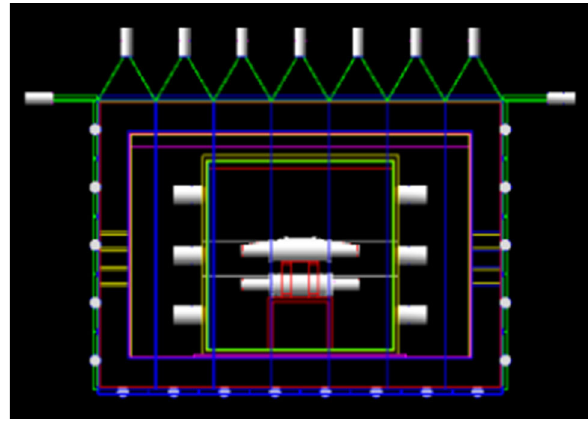
Fig. 23 A comparison of the Crystal-1 energy spectrum before (black line) and after (red line) application of the LS veto. The γ -ray radiation from daughter nuclei of the 238 U and 232 Th decay chains in the external shieldingmaterialsarereducedsignificantlybytheLSvetorequirement. The lower panel shows a reduction in percentage as a function of the energy